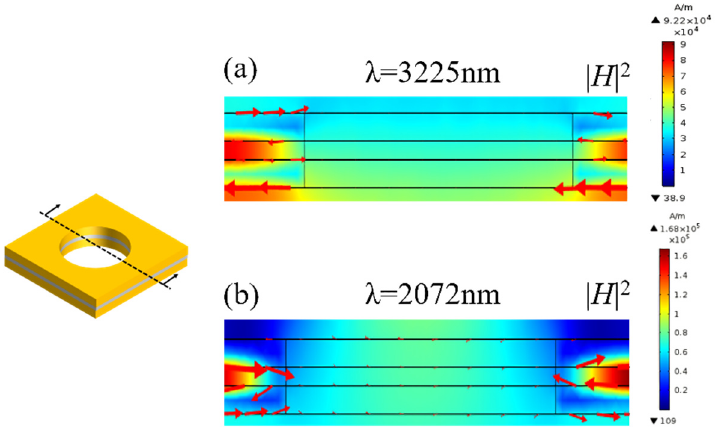
Figure 4. The magnetic field of the fishnet structure in the x-z plane in the resonant region of λ = 3225 nm ( a ) and λ = 2072 nm ( b ) (the arrow shows the direction of the current).